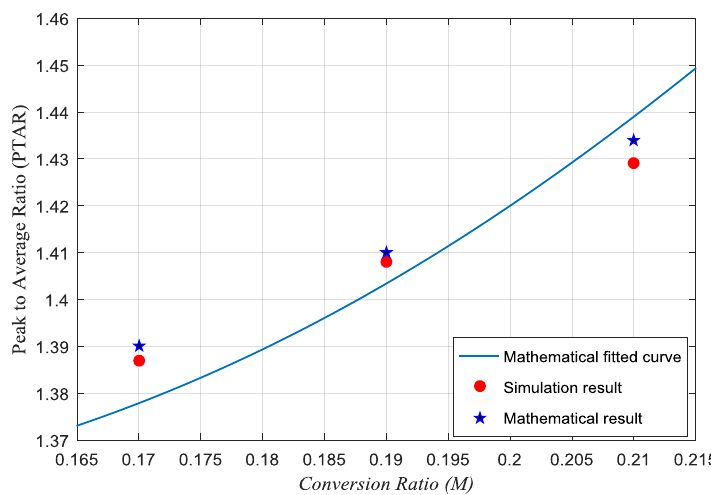
Figure 15. Obtained PTAR at different values for conversion ratio ( M ) from mathematical model, practical and simulation. Figure 11. ( a ) Model of the bode plot. ( b ) Bode diagram of the system transformation function.